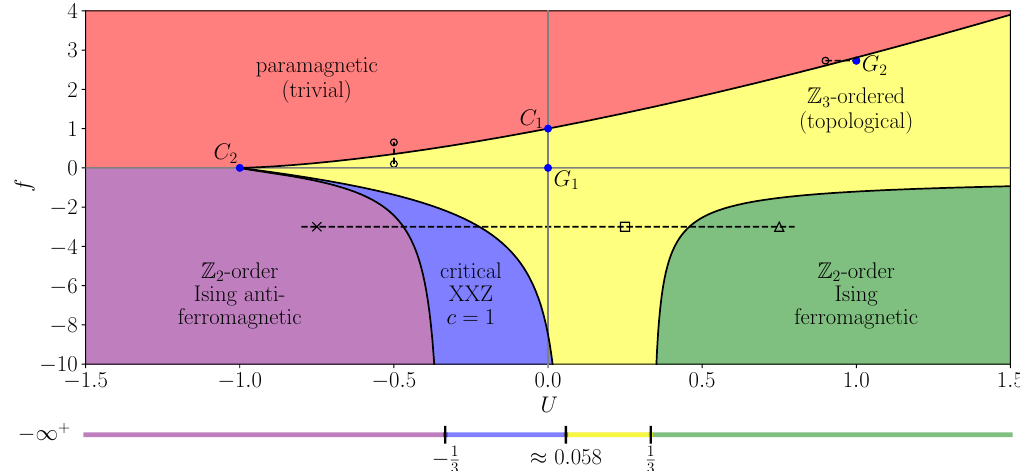
Figure 2: Phase diagram of the extended parafermion chain / (cid:90) distinguish the following four gapped phases: a paramagnetic phase (red), a topolog- ical phase (yellow), an Ising antiferromagnetic (purple) and an Ising ferromagnetic (green) phase. Furthermore, we identify a critical XXZ like phase (violet) with cen- tral charge c = 1. We also indicate the transition points C to specific conformal field theories, and the points G becomes frustration-free and thus allows an exact description of the ground state. At the bottom we show the phase diagram in the limit f → −∞ + obtained analytically in Section 7.1. The dashed lines indicate cuts along which detailed results are shown in Figures 3, 4, and 8(b) (with the corresponding symbols for marked